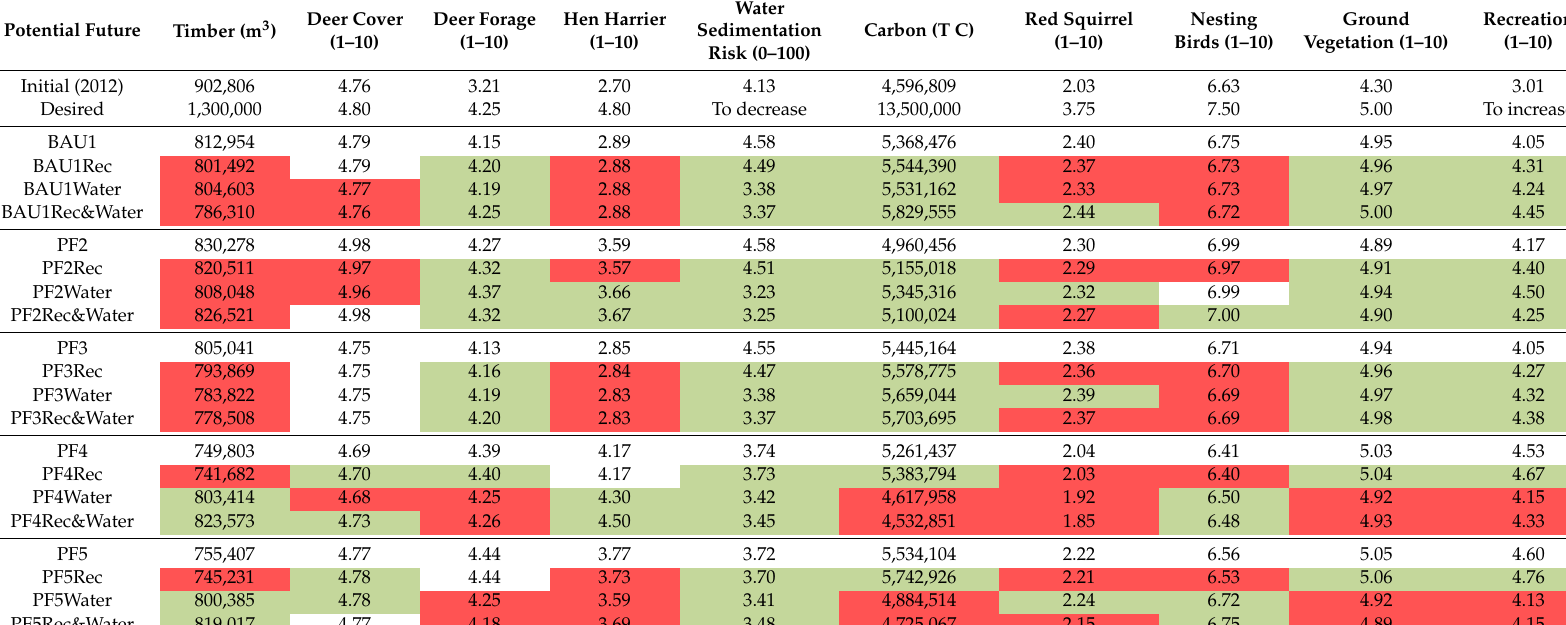
Table 12. Summary of the ES outputs (average values for the years 2012 to 2082) for all backcasting policies assessed for robustness in the WP CSA. The red cells highlight the ESs that, compared to their level in the PF, move away from the stakeholder desired endpoint when the backcasting policies are implemented; the green cells highlight a move towards the desired end point; while the ESs in the cells with no shading are unchanged from those for the